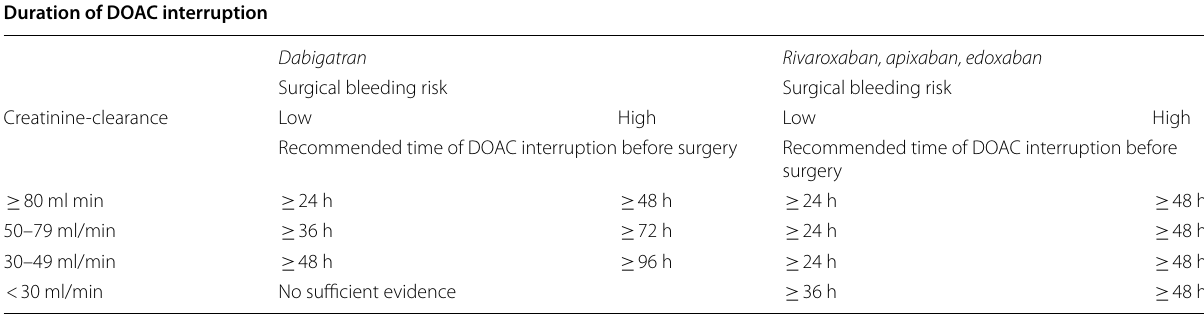
Table 2 Perioperative management of patients taking DOAK during elective interventions (based on [101]) Duration of DOAC